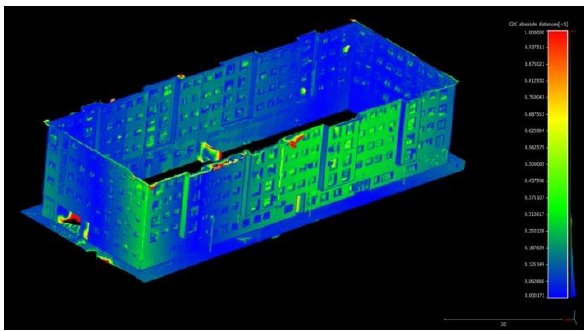
Figure 3. Comparison with laser scanner Faro Focus3D. Distance map between both 3D models resulted.